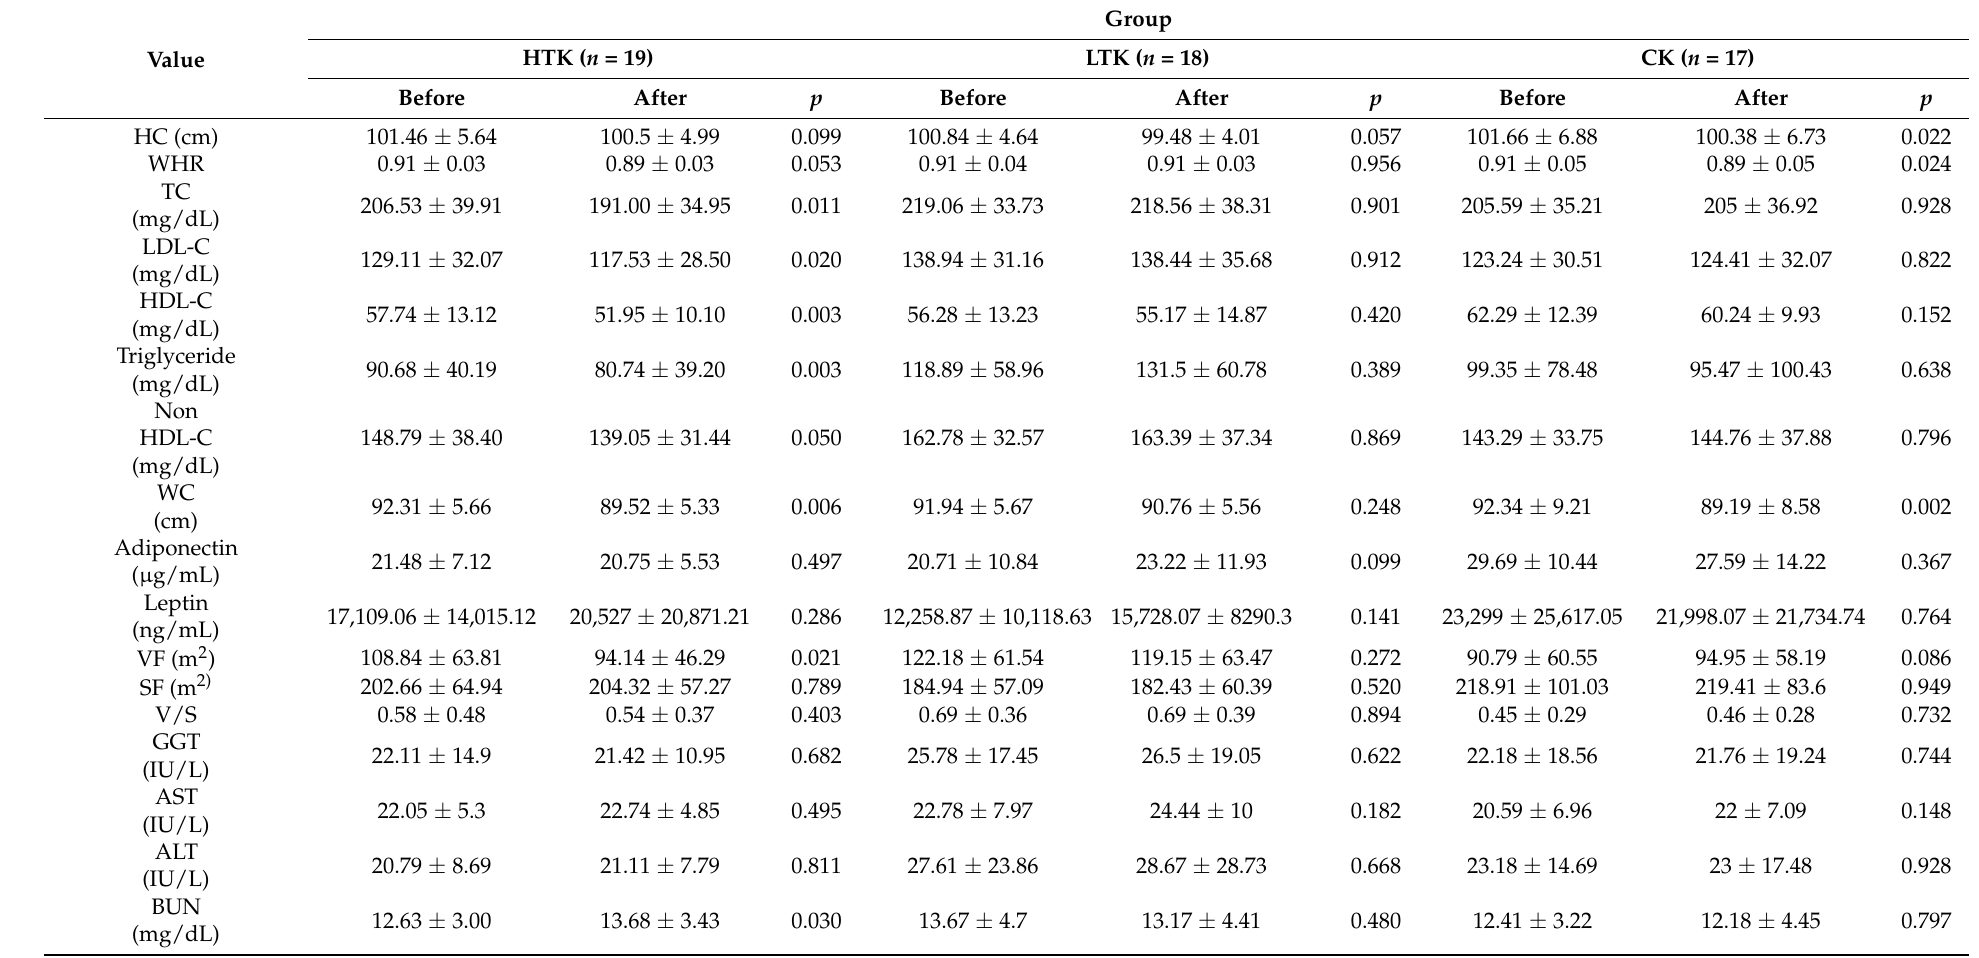
Table 3. Efficacy comparison between the three